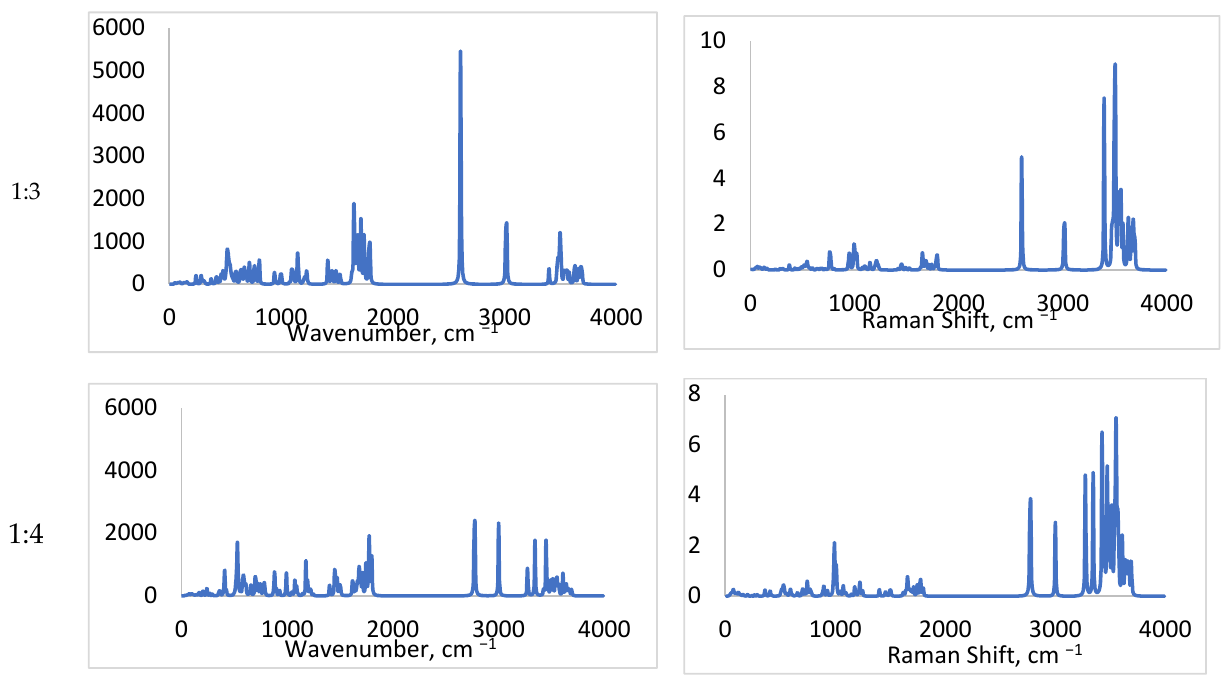
Figure 12. Vibrational spectra of the ammonium sulfamate–urea system with different component ratios.